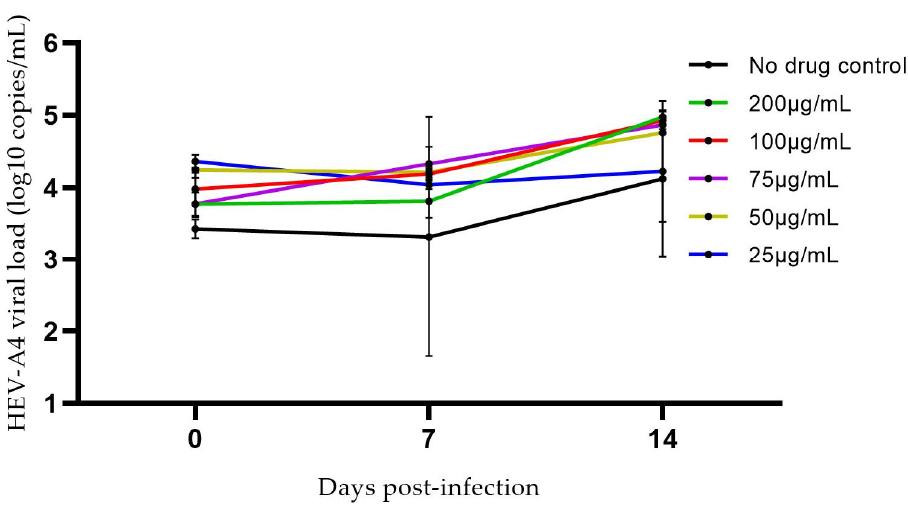
Figure 6. Growth of hepatitis E virus (HEV) in PLC/PRF/5 cells maintained in MEM-A supplemented with varying concentrations of ribavirin for HEV-A genotype 4 (HEV-A4). Each data point represents the mean of 3 replicates. Error bars represent standard error of mean. Limit of detection of the RT-qPCR assay is represented by the dashed line (50 copies per mL for HEV-A4).